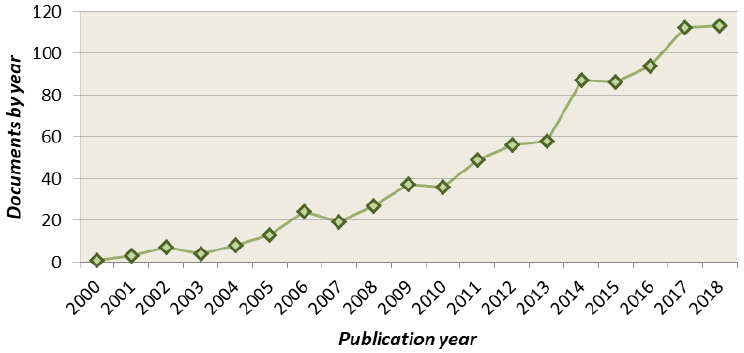
Figure 1. Search of literature related to ion mobility spectrometry (IMS) in food analysis from 2000 to 2018 on Scopus database. The terms “ion mobility spectrometry” and “food” have been included in the search